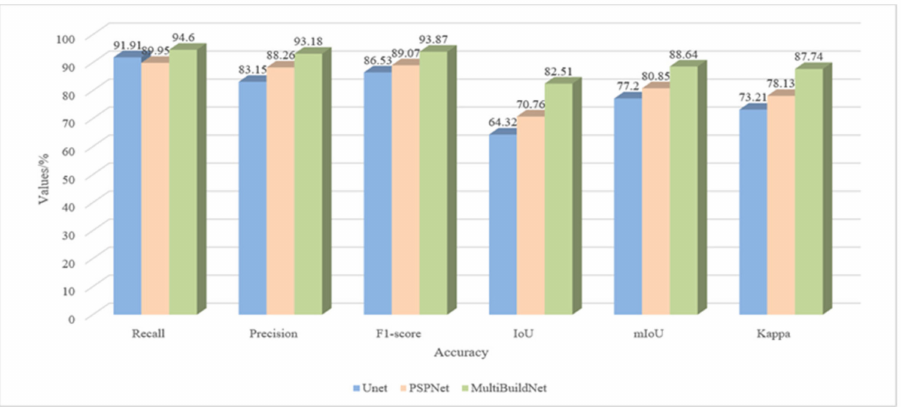
Figure 17. Accuracy of building footprint segmentation from large-scale remote sensing